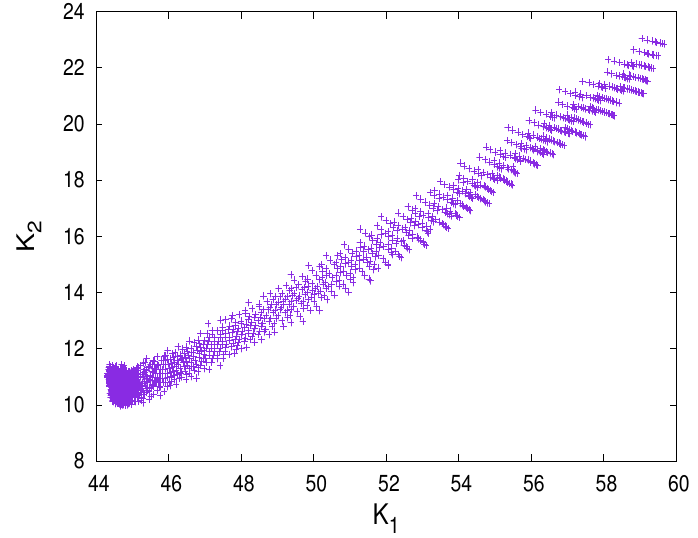
Figure 5 . Decay parameters corresponding to lightest ( N 1 ) and next-to-lightest ( N 2 ) RH neutrinos for the parameter space allowed by 3 (cid:27) global (cid:12)t of oscillation data.